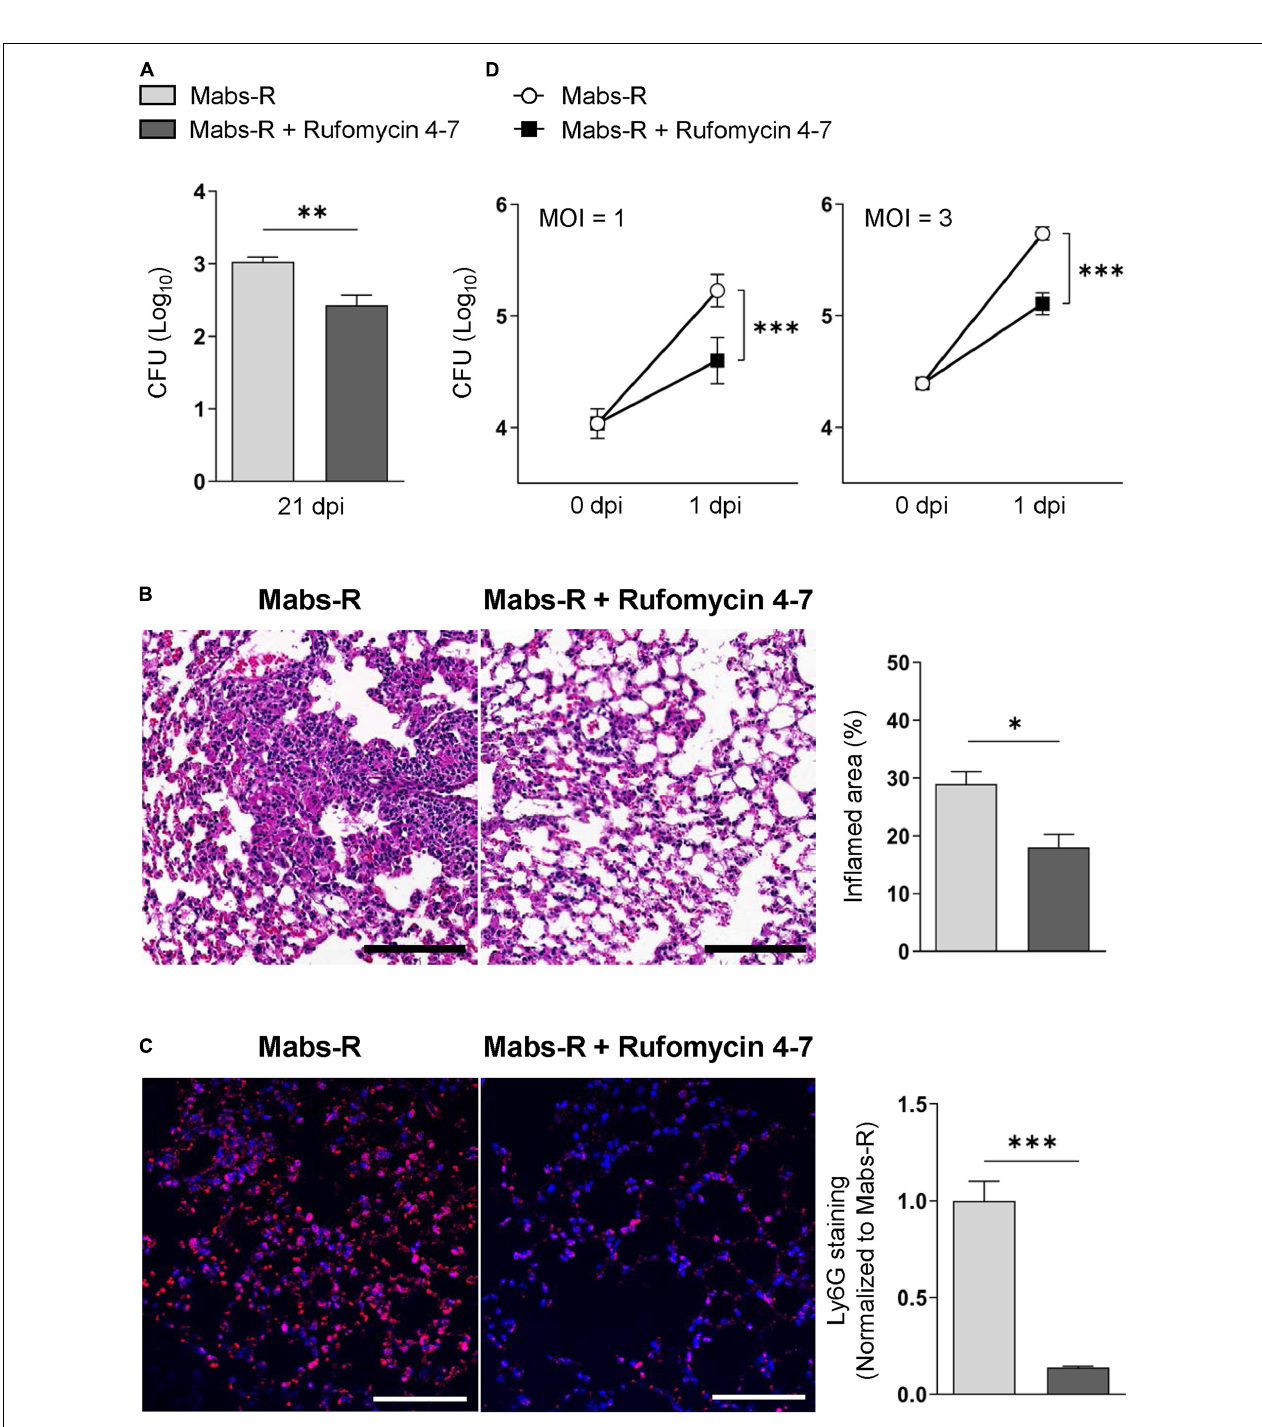
FIGURE 1 | Rufomycin 4–7 treatment increases antimicrobial effects against mycobacterial infection in vivo and in vitro . (A) Mice were infected with Mabs-R (1 × 10 6 CFU) intranasally, followed by administration of Rufomycin 4–7 (200 mg/kg, three times per week; by gavage) and sacrificed at 21 dpi. Bacterial loads in lung tissues for infected mice ( n = 5; each group) were determined by CFU assay. (B) The sectioned lung tissues of infected mice ( n = 3; each group) from panel (A) were H&E stained (scale bar: 300 µ m), and the inflamed area of each group was quantified. (C) The sectioned lung tissues from panel (A) were stained with anti-Ly6G (red) and DAPI (blue) (scale bar: 25 µ m), and the relative fluorescence intensity of Ly6G-stained neutrophils were quantified ( n = 9 for each group; at least 200 cells per image). (D) BMDMs were infected with Mabs-R (MOI = 1 or 3) for 2 h and then incubated with solvent control (sc) or Rufomycin 4–7 (10 µ M) in the freshly changed media. Intracellular survival of Mabs-R was determined by CFU assay at 0 and 1 dpi. ∗ p < 0.05, ∗∗ p < 0.01, and ∗∗∗ p < 0.001. Statistical analysis was determined with unpaired t -test (A–C) or two-way ANOVA (D) . Data are presented as means ± SEM (A–C) , or ± SD from at least three independent experiments performed in triplicate (D) . Images are representative of three independent experiments (B,C) . MOI, multiplicity of infection; dpi, days post-infection.